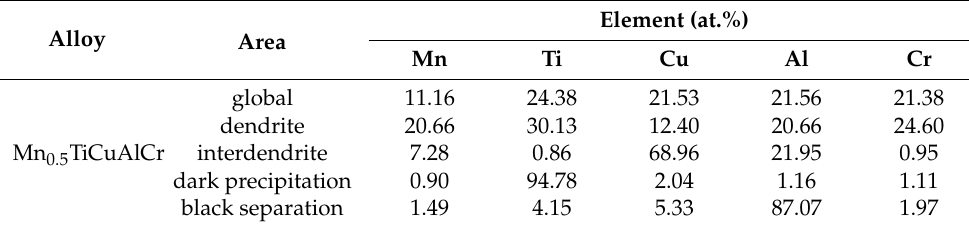
Table 5. The chemical composition of Mn 0.5 TiCuAlCr